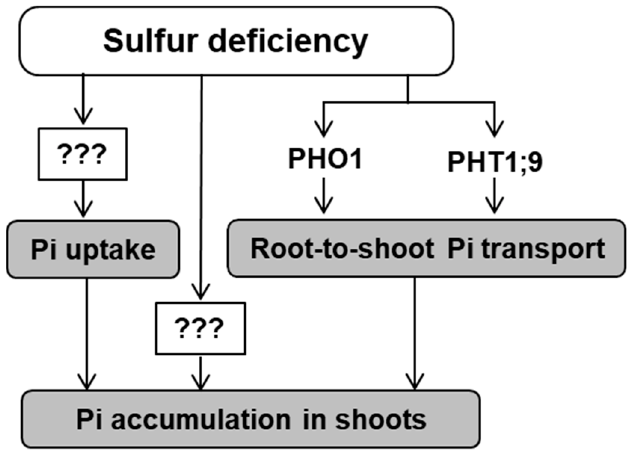
Figure 7. Effects of –S on Pi accumulation, uptake, and transport to shoot. Under –S, higher Pi uptake and Pi transport from roots to shoots were confirmed in this study, which ultimately leads to higher Pi accumulation in shoots under –S listing it as part of –S response in plants. Two transporters, namely, PHT1;9 and PHO1, were found to contribute to the increased Pi transport from root to shoot under –S. Further investigations required to identify the molecular mechanisms regulating the increased Pi uptake and accumulation under –S. Arrows ( → ) indicates “stimulated by –S”.